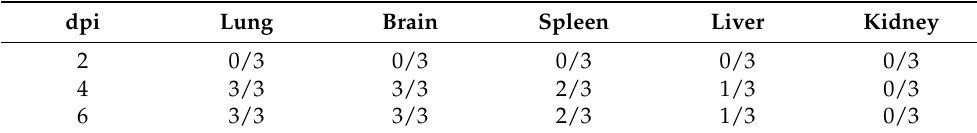
Table 2. EHV-8 detection in several organs of BALB/c mice by